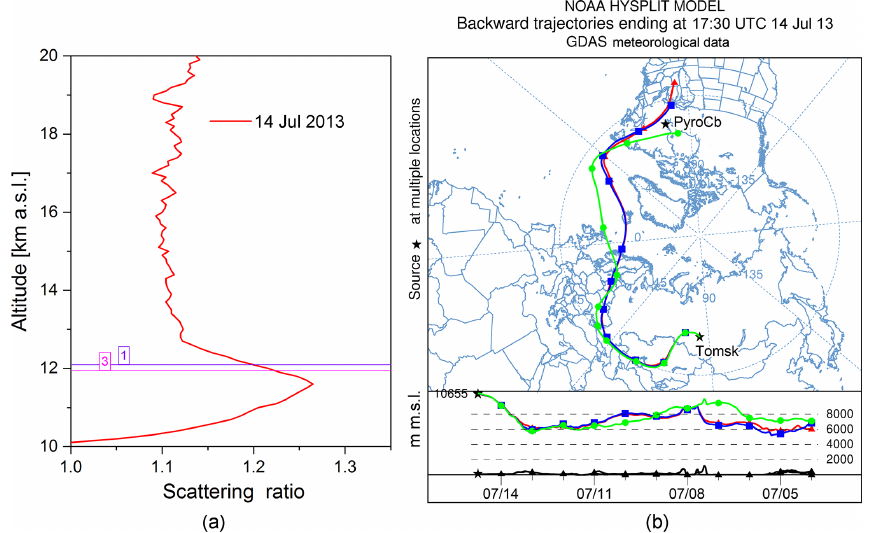
Figure 5. (a) Detection of the Eastmain pyroCb plume in the UT–TR over Tomsk. The numbers 1–3 indicate the tropopause altitudes estimated in Kolpashevo, Emeljanovo, and Novosibirsk, respectively, at 17:30UTC on 14 July 2013. (b) Air mass backward ensemble trajectories started from altitude of 10.6–10.7km over Tomsk at the same time.